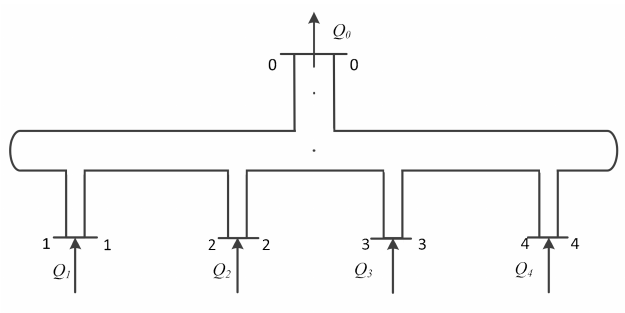
Figure 2. Schematic diagram of MCCS pipe